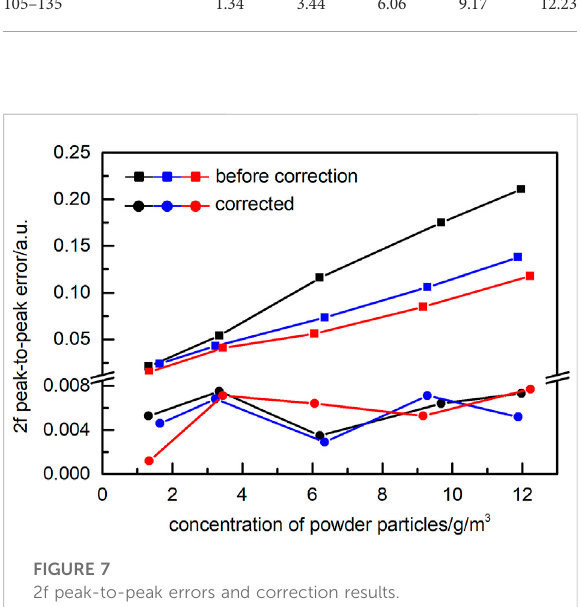
FIGURE 7 2f peak-to-peak errors and correction